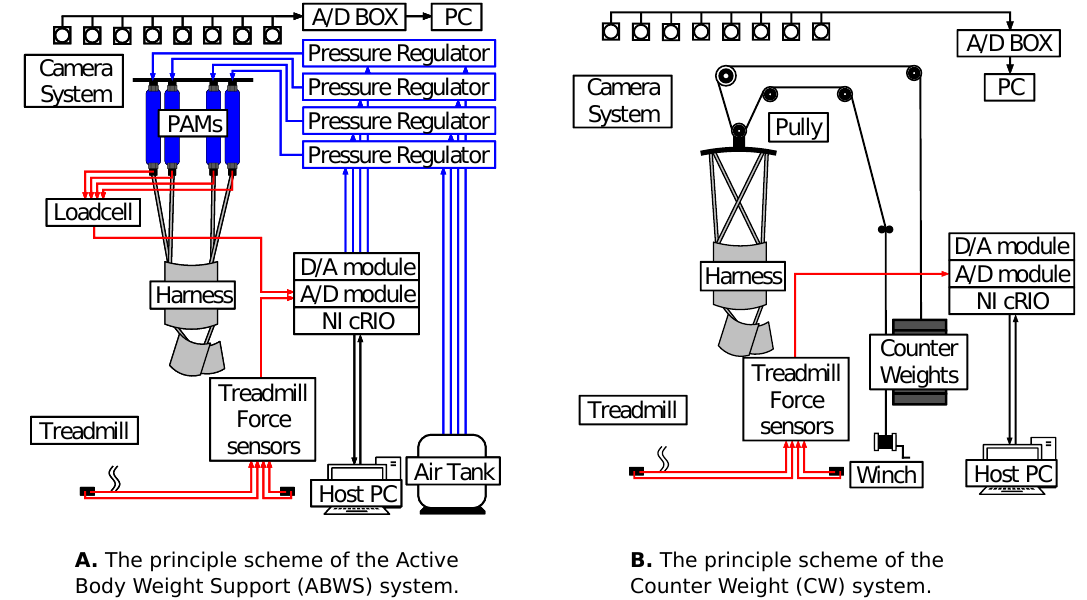
Figure 1. The principle scheme of the Active Body Weight Support (ABWS) system ( A ) and the Counter Weight (CW) system ( B ) which integrated with the treadmill for gait